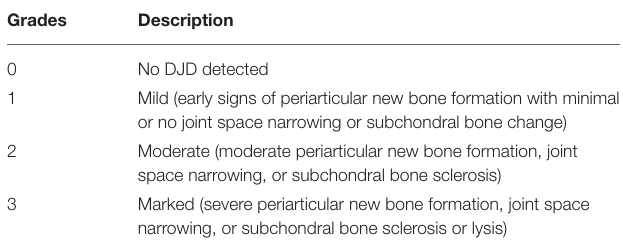
TABLE 2 | Staging system for histologic evaluation of the mandibular head and fossa of the TMJ (27).